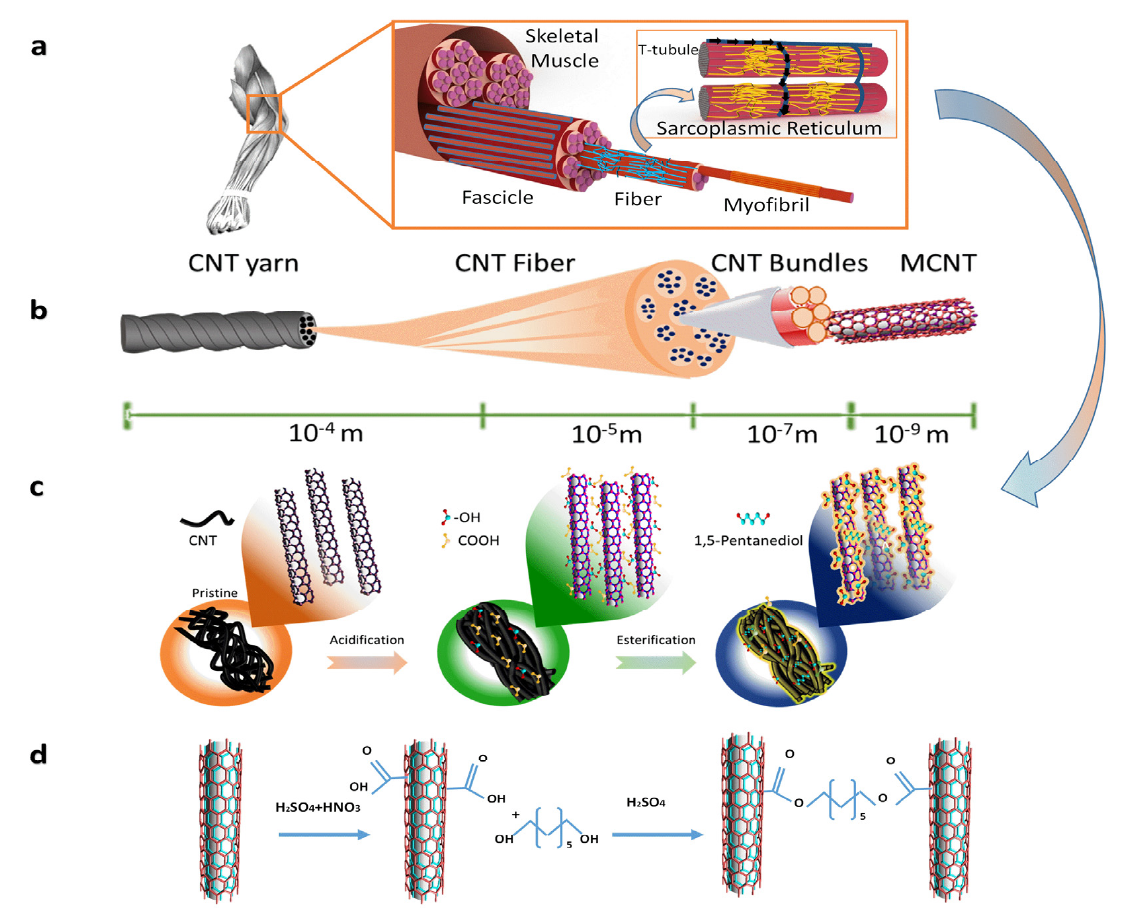
Figure 1. ( a ) Hierarchical structure of skeletal muscle with sarcoplasmic reticulum showing a path for electrons to move through T tubules. ( b ) Schematic demonstration of the hierarchical structure of carbon nanotube presenting CNT yarn, CNT fiber, CNT bundles, and CNTs with their scales. ( c ) Illustration of chemical modification of pristine CNTs towards acidified and esterified structures. ( d ) Chemical reaction between CNTs due to acidification and esterification.